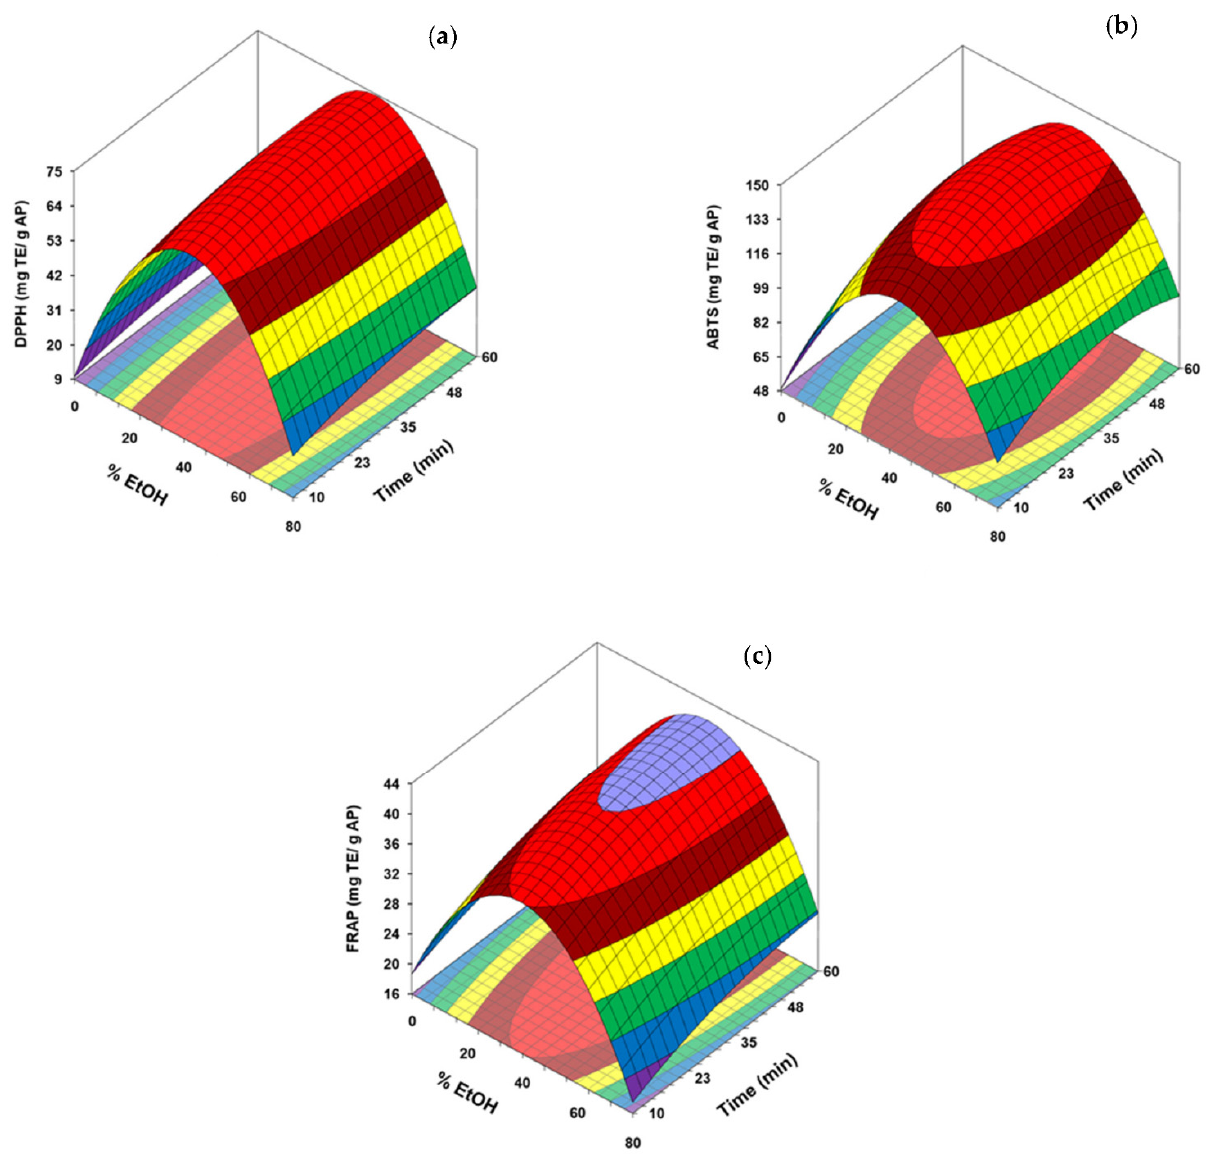
Figure 3. Response surface of DPPH ( a ) ABTS ( b ) and FRAP ( c ) for avocado peel (AP) as a function of ethanol concentration and ultrasonication time. Table 4. Validation of the predicted values at optimal conditions of